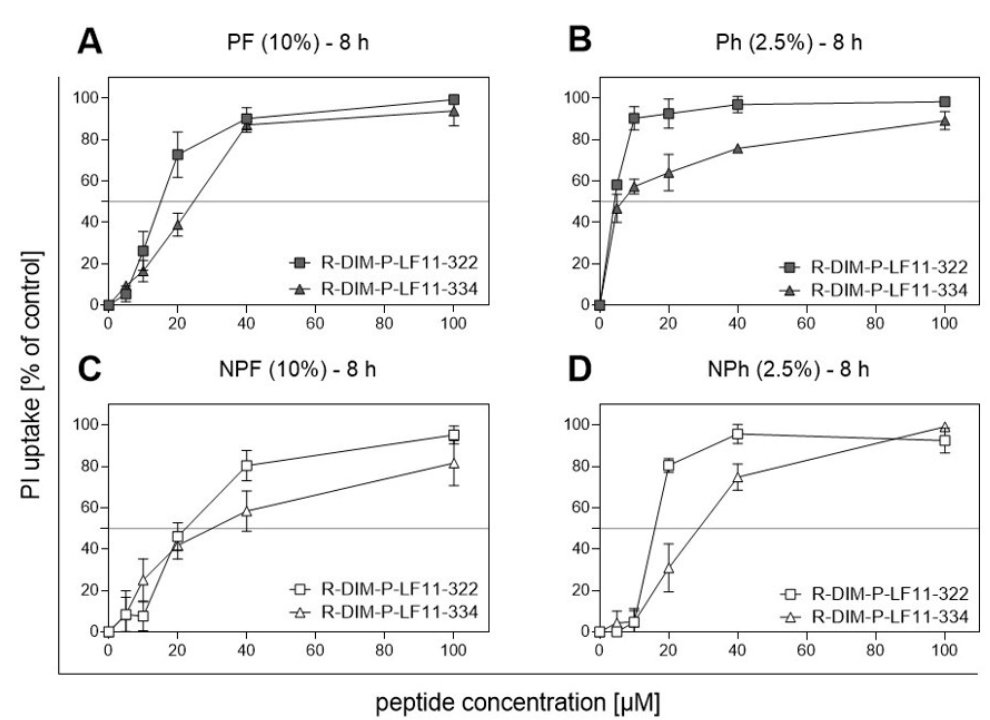
Figure 7. Cytotoxic capacity of R-DIM-P-LF11-322 and R-DIM-P-LF11-334 peptides on all four MUG Mel3 cell lines. Cytotoxicity was measured by PI-uptake in the presence of 10% FBS or 2.5% hPL after 8 h of incubation. ( A ) MUG Mel3 PF, ( B ) MUG Mel3 Ph, ( C ) MUG Mel3 NPF, and ( D ) MUG Mel3 NPh. Data for PI measurements from at least three independent experiments are presented as mean ±